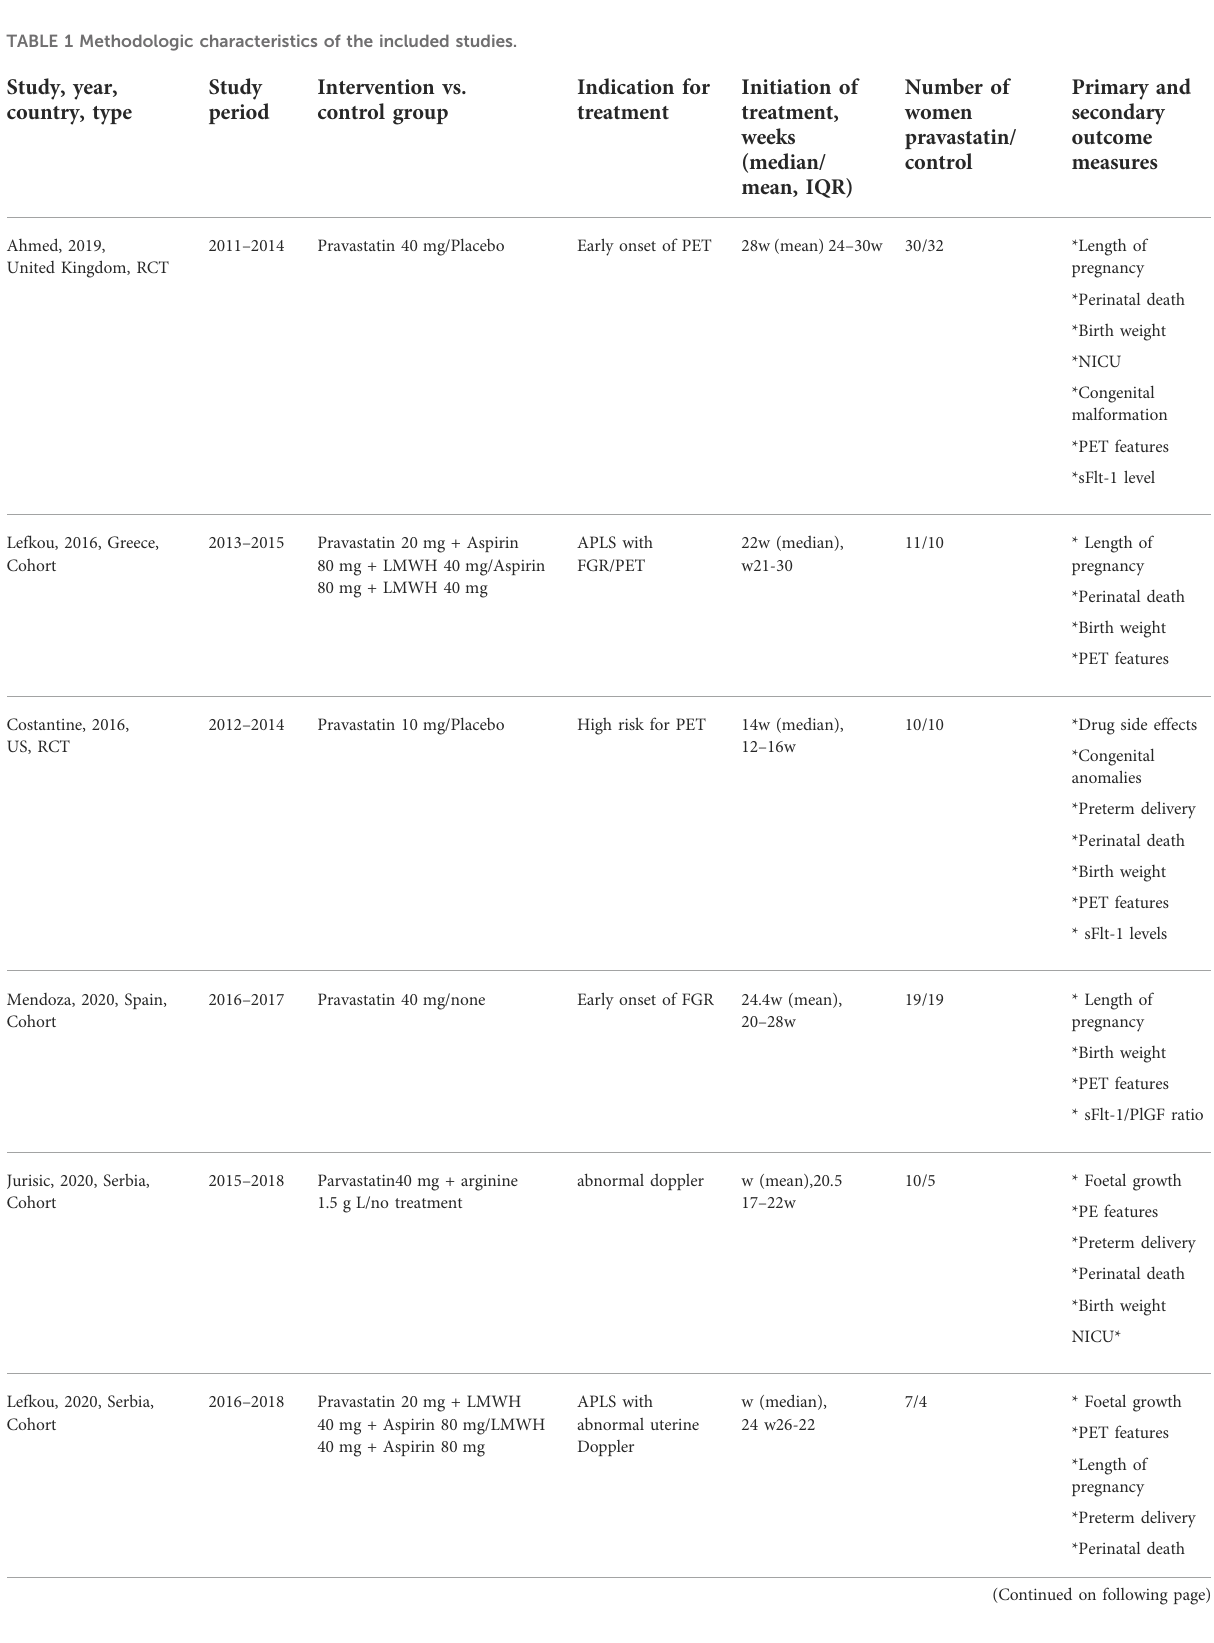
TABLE 1 Methodologic characteristics of the included